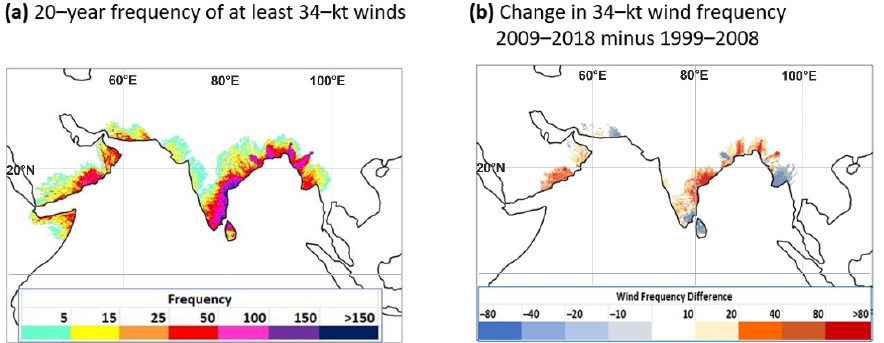
Figure 10. Frequency of at least 34 kt winds after landfall based on the DAV wind radii for ( a ) 1999–2018; and ( b ) change in frequency from the first to the second decade. Similar to the shift in TC track frequency (Figure 5), the frequency of TC winds of at least 34 kts affecting coastal and inland regions has shifted over the past 20 years such that